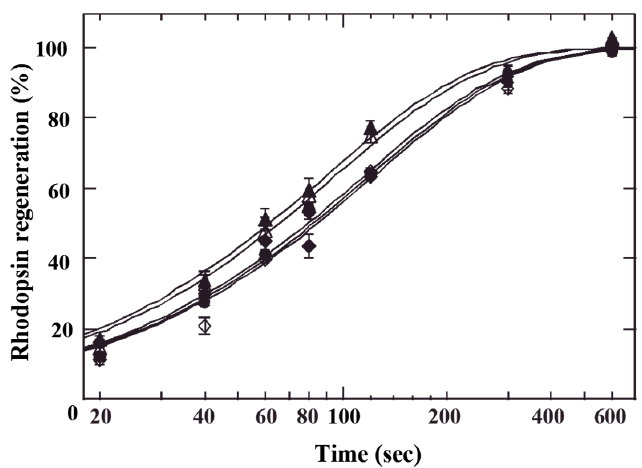
Figure 3. AC effects of the rhodopsin regeneration time course. ( • ) control; ( ◇ ) D3G; ( ◆ ) D3R; ( △ ) C3G; ( ▲ ) C3R. Rhodopsin regeneration was fitted to an exponential function of 1-exp (–t/ τ ). Control, τ = 114 sec (R 2 = 0.997); D3G, τ = 122 sec (R 2 = 0.988); D3R, τ = 119 sec (R 2 = 0.993); C3G, τ = 94 sec (R 2 = 0.994) and C3R, τ = 89 sec (R 2 = 0.994). Values are the mean of nine experiments, and vertical bars